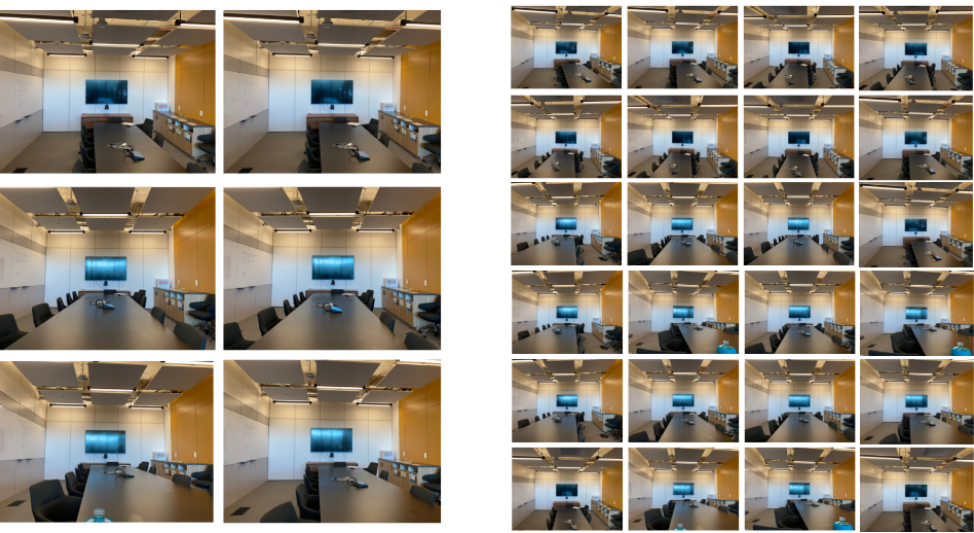
Figure 4. Image synthesis example. From a reduced number of input image views, NeRF-- renders a predefined number of high-quality new ones. Original input images can be downloaded from the corresponding repository in